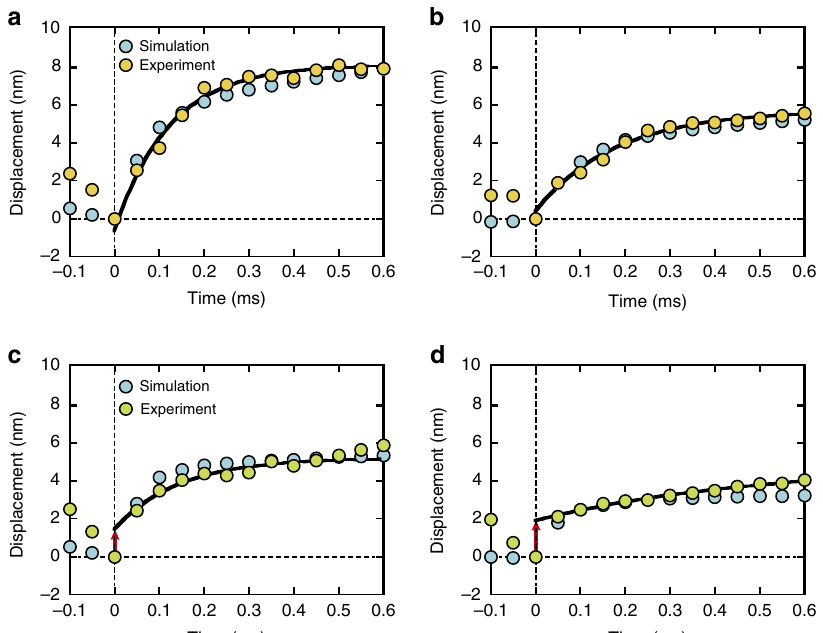
Figure 4 | Characteristics of step curves during the rising phase of actin displacement. ( a , b ) Ensemble-averaged displacement of actin filaments at 1mM ATP for low loads (mean of 2.7pN, n ¼ 42 for experiment; mean of 2.5pN, n ¼ 2,455 for simulation) in a and high loads (mean of 23.1pN, n ¼ 179 for experiment; mean of 18pN, n ¼ 487 for simulation) in b . ( c , d ) Ensemble-averaged displacement of actin filaments at 10 m M ATP for low loads (mean of n ¼ 545 for simulation) in d . The black lines are single exponential curves ( d ¼ d s {1 (cid:2) exp[ (cid:2) t / t ]} þ d 0 ) fitted to experimental data starting from one sampling point after the onset point ( t ¼ 50 m s). The fitting curves extended to t ¼ 0 pass close to the origin for 1mM ATP ( d 0 ¼ (cid:2) 0.6 or 0.4nm, d s ¼